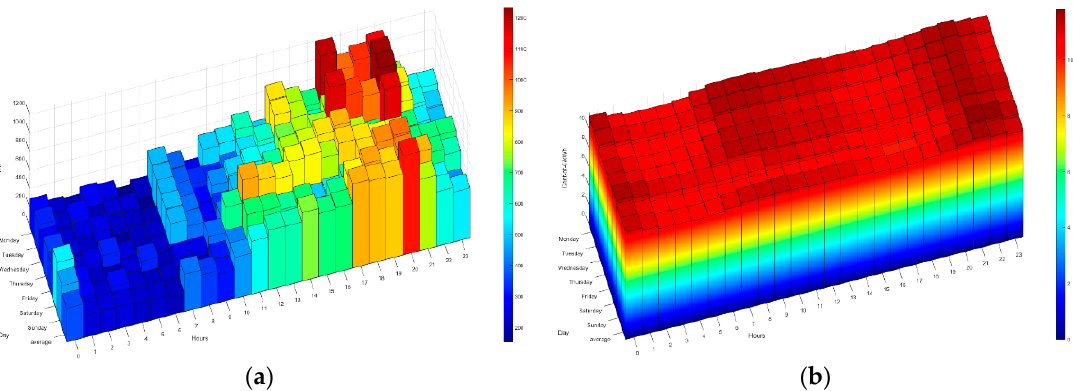
Sensors 2021 , 21 , x FOR PEER REVIEW Figure 14. P0 and P1. ( a ) Average consumption (Wh) and ( b ) average prices (€ cents per kWh) during P0 and P1 (tariff 2.0A).